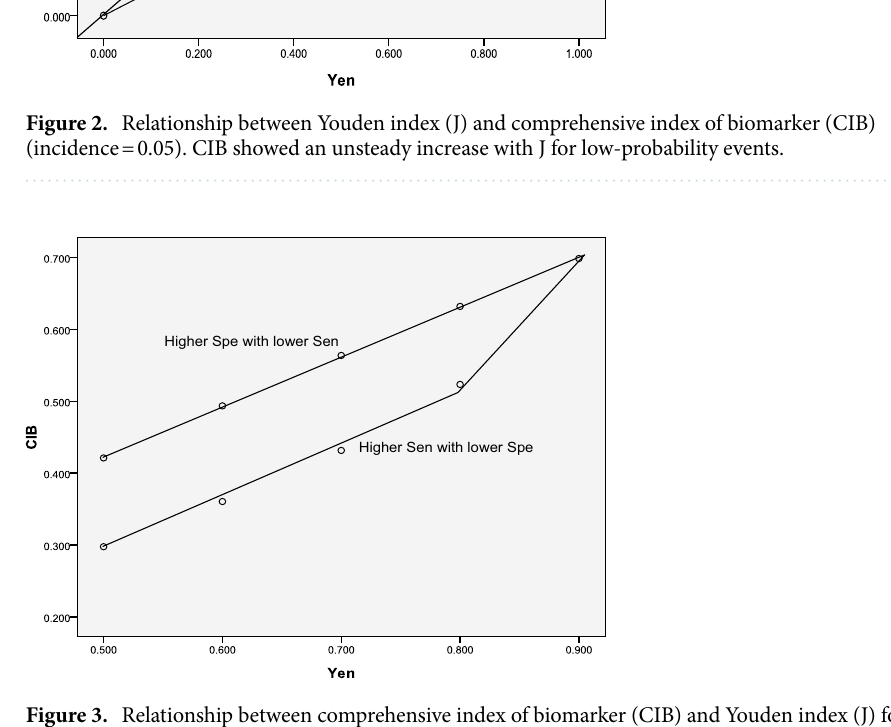
Figure 3. Relationship between comprehensive index of biomarker (CIB) and Youden index (J) for different sensitivity (Sen) and specificity (Spe) values (incidence = 0.05). There was a difference in CIB between biomarkers with the same J that had higher Spe and higher